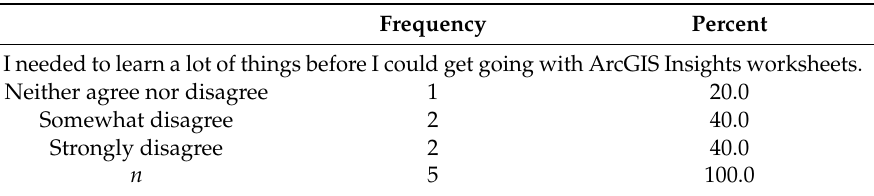
Table 12. Percentages and Frequencies, Q55.